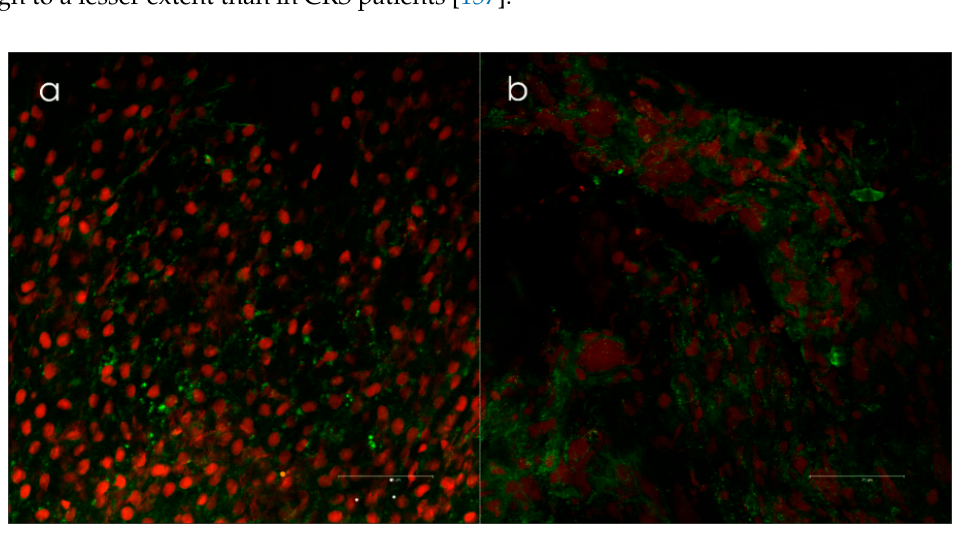
Figure 3. ( a ) Biofilm positive samples taken from the lateral side of concha media visualized by confocal scanning laser microscopy ( Leica TCS SP2 AOBS ) and ( b ) live/dead-staining (Invitrogen`s LIVE/DEAD BacLight™, Invitrogen, Burlington, Canada). Epithelial cells are red, and the bacteria are green. Biofilms were scored when clusters of bacteria with intact membranes were present in both the x-y and x-z axes. Courtesy of Dr. Kjell Arild Danielsen.